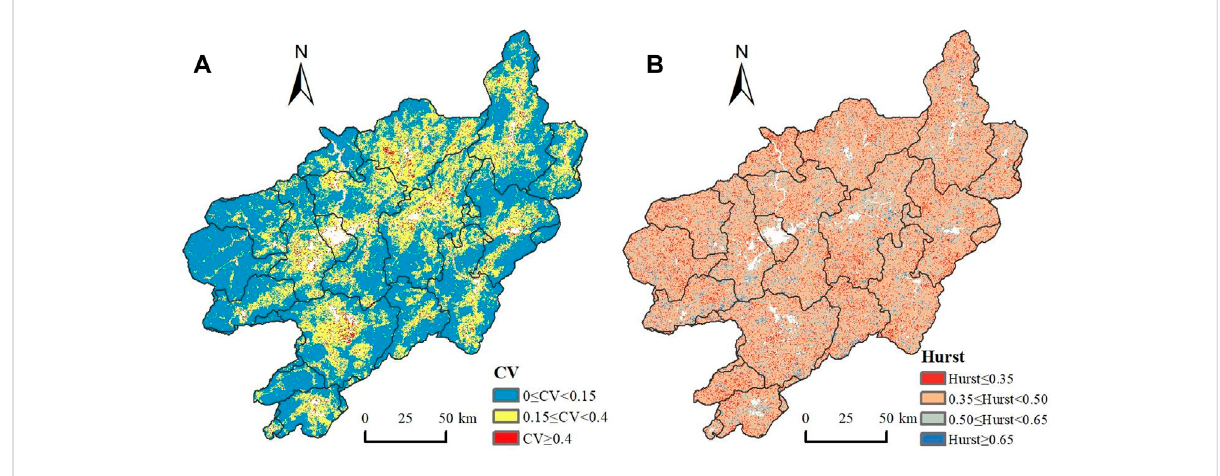
FIGURE 8 Spatial distribution of coef fi cient of variation (CV) and Hurst exponent of FVC in the upper reaches of Ganjiang River Basin during 2000 – 2020. (A) Distribution of CV (B) Distribution of Hurst